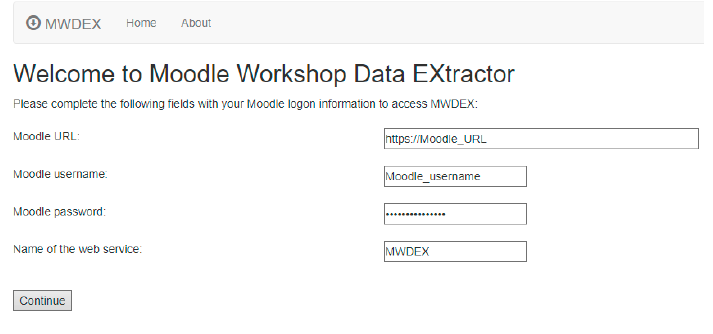
Figure 4. MWDEX home page.